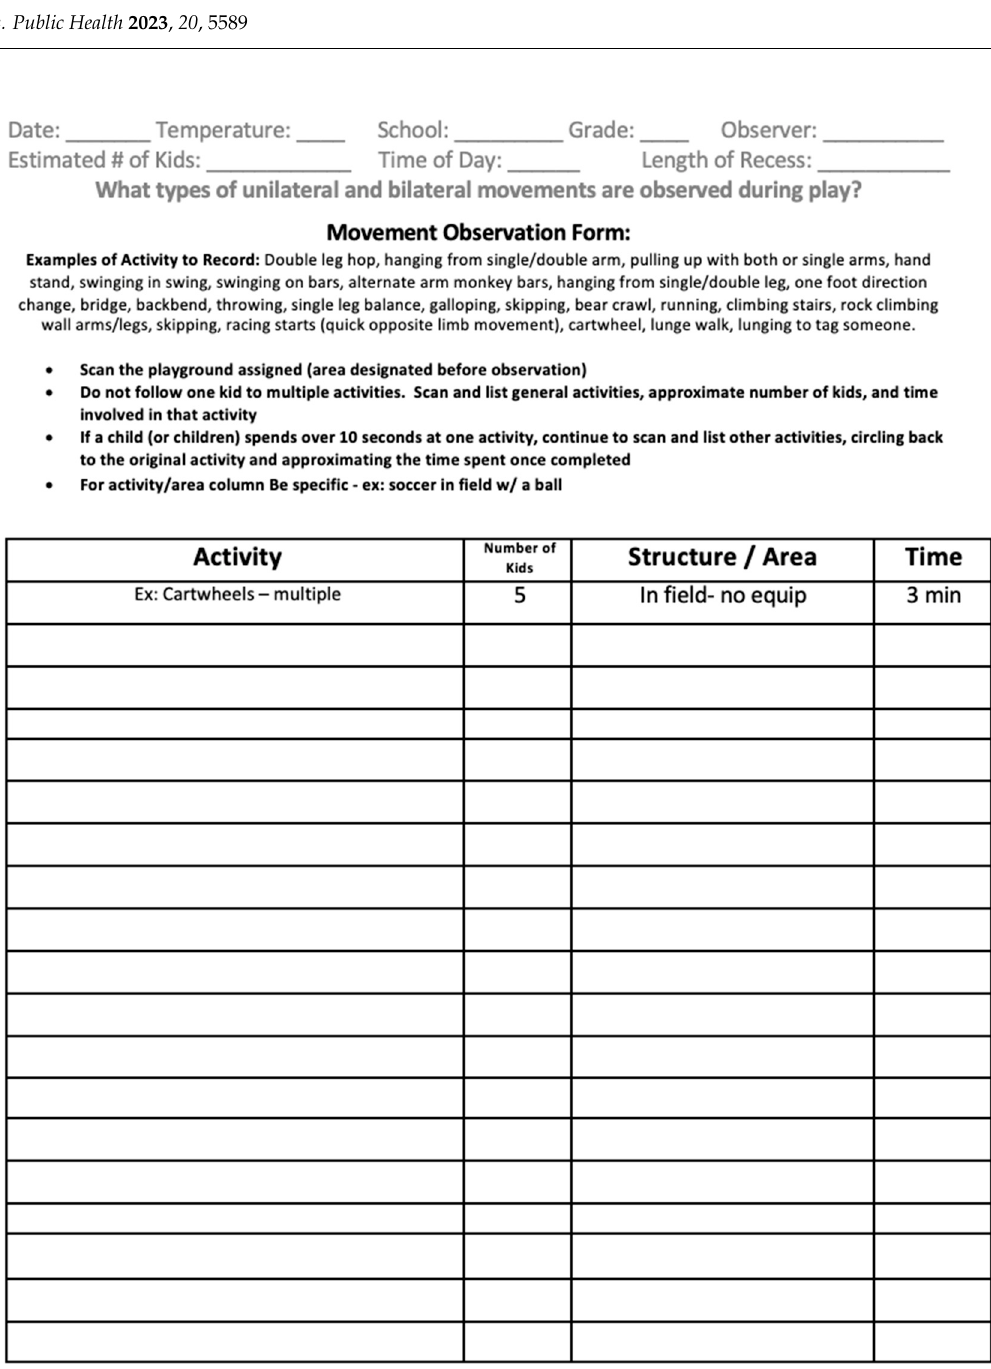
Figure 1. First Movement Pa tt ern Observation Tool.